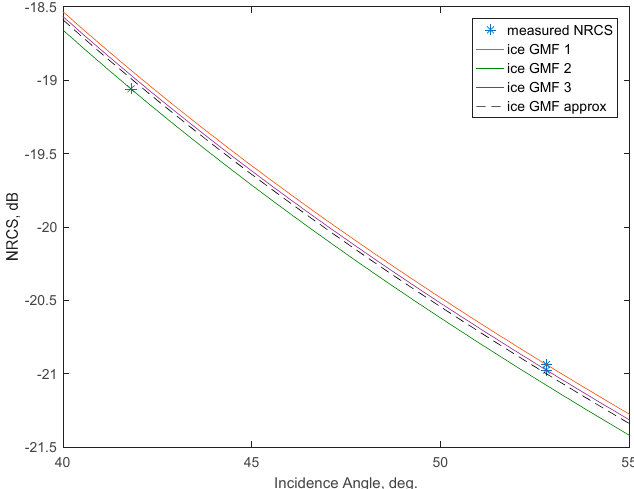
Figure 6. An example of sea ice GMF approximation from the simulated “measured” NRCSs for the selected cell by the fore-, mid-, and aft-beams at incidence angles of 52.8°, 41.8°, and 52.8°, respectively.